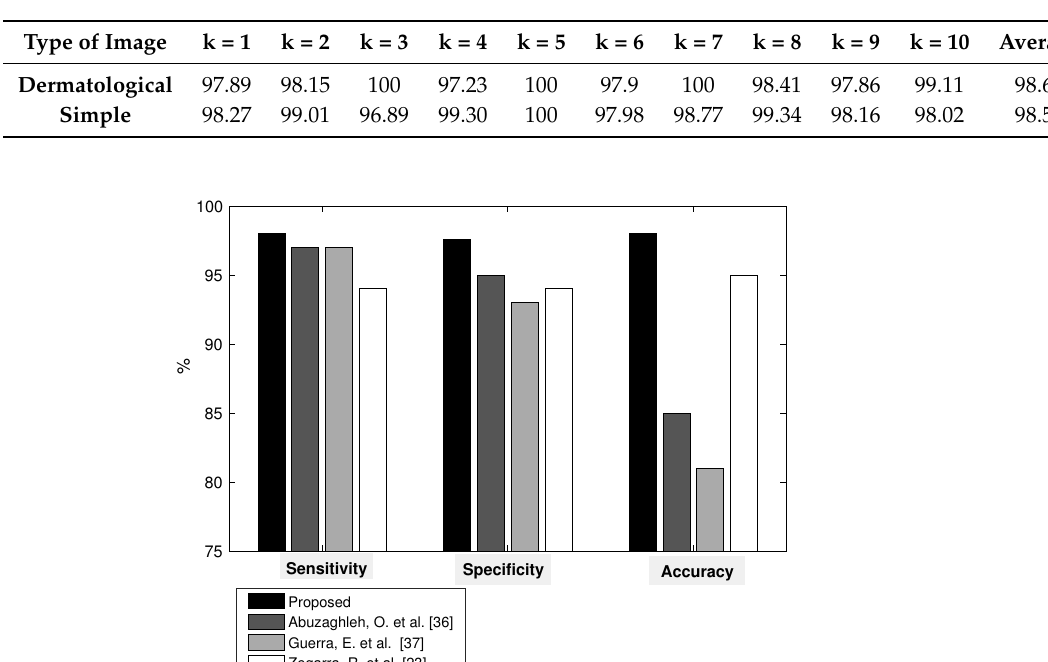
Table 4. 10-fold cross-validation accuracy.